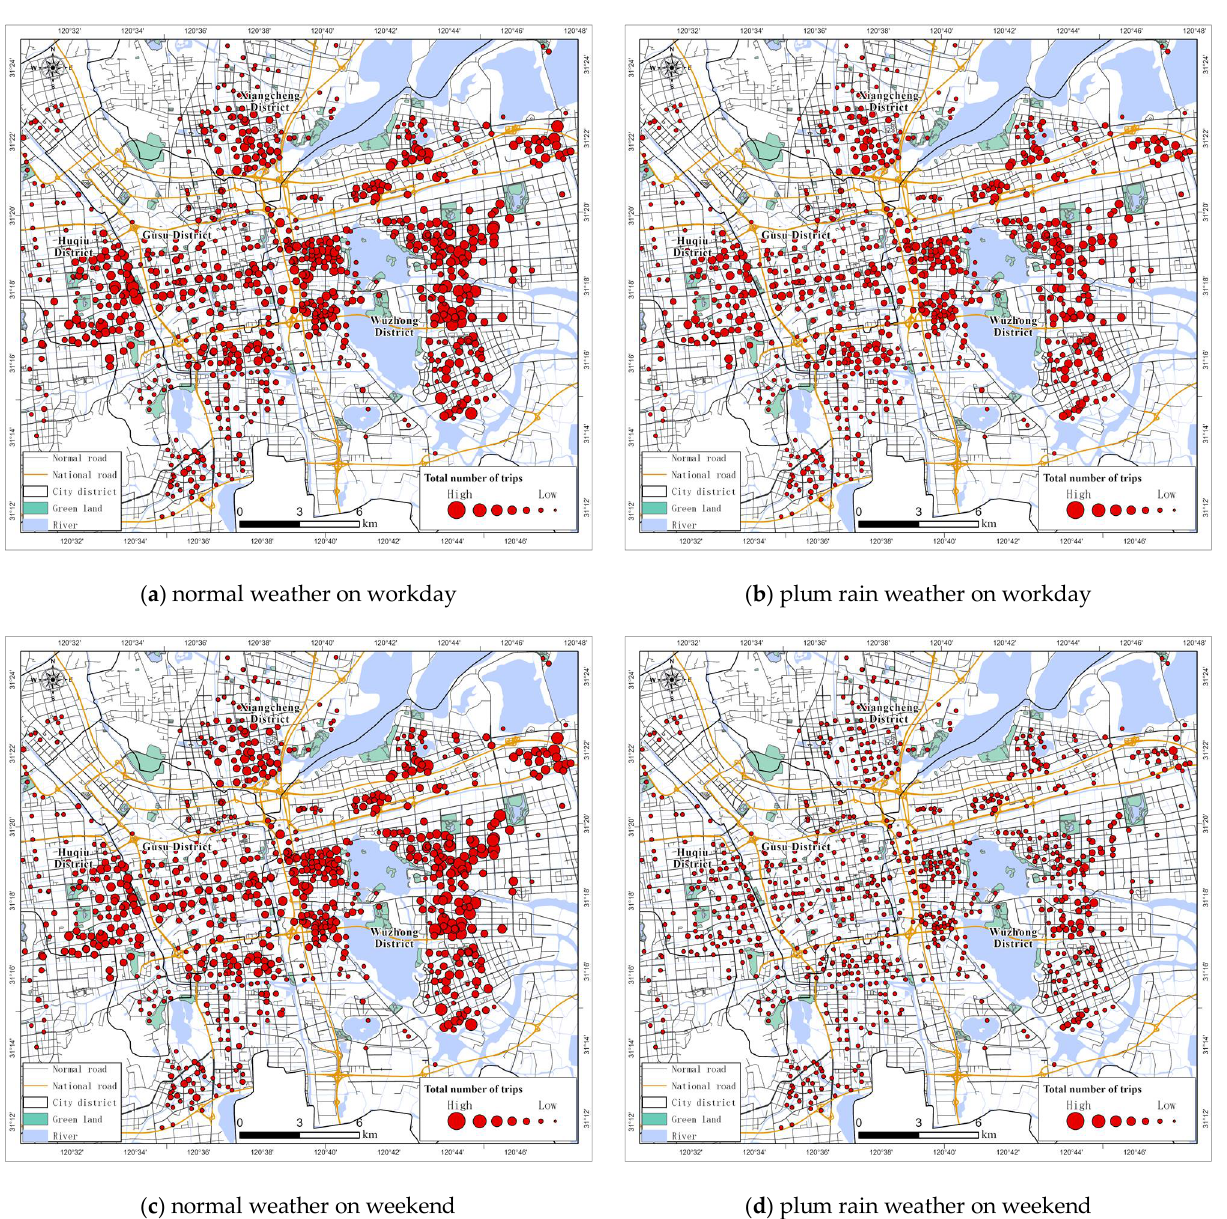
Figure 6. Comparison of public bicycle trips in normal weather and PRS. Table 1. Statistical characteristic of predicted and observed value.